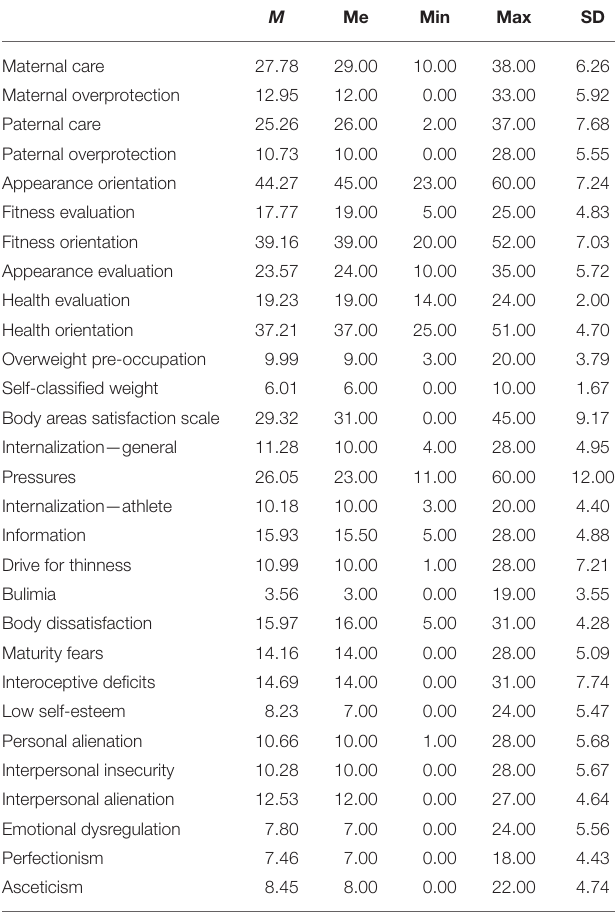
TABLE 2 | Selected characteristics of the study